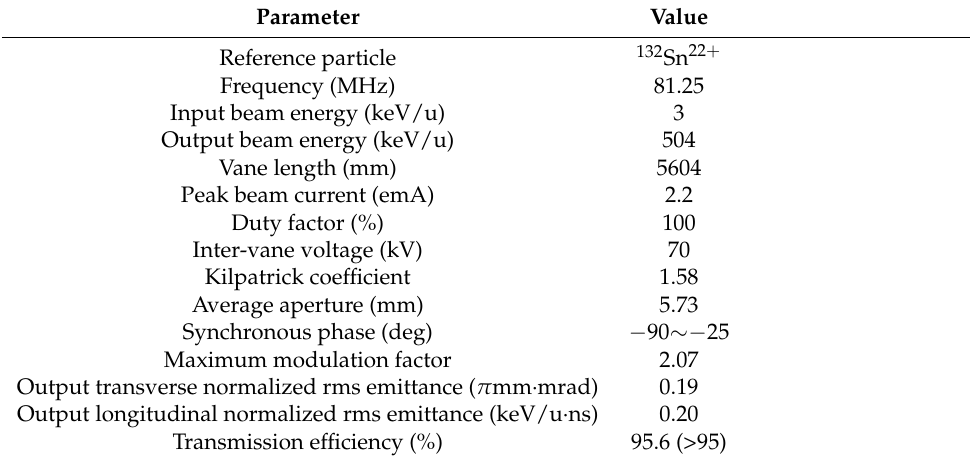
Table 1. Main dynamic design parameters.